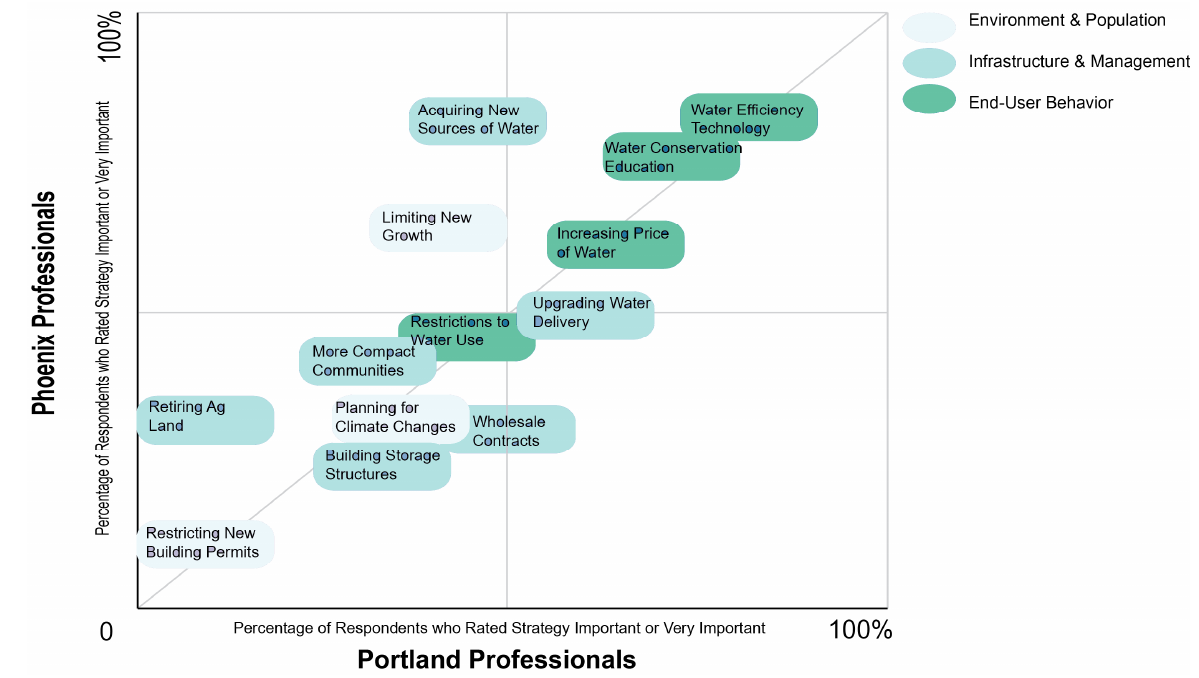
Figure 4. Water Resource Strategies rated at least 7/10 on a scale of importance, by region.